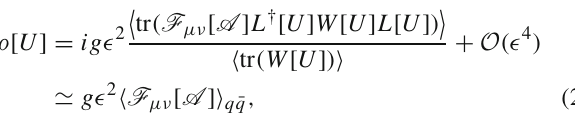
loop operator W [ U ] and the plaquette U P . See Fig. 1 for the setup of the operator W [ U ] L [ U ] U P L † [ U ] . In the